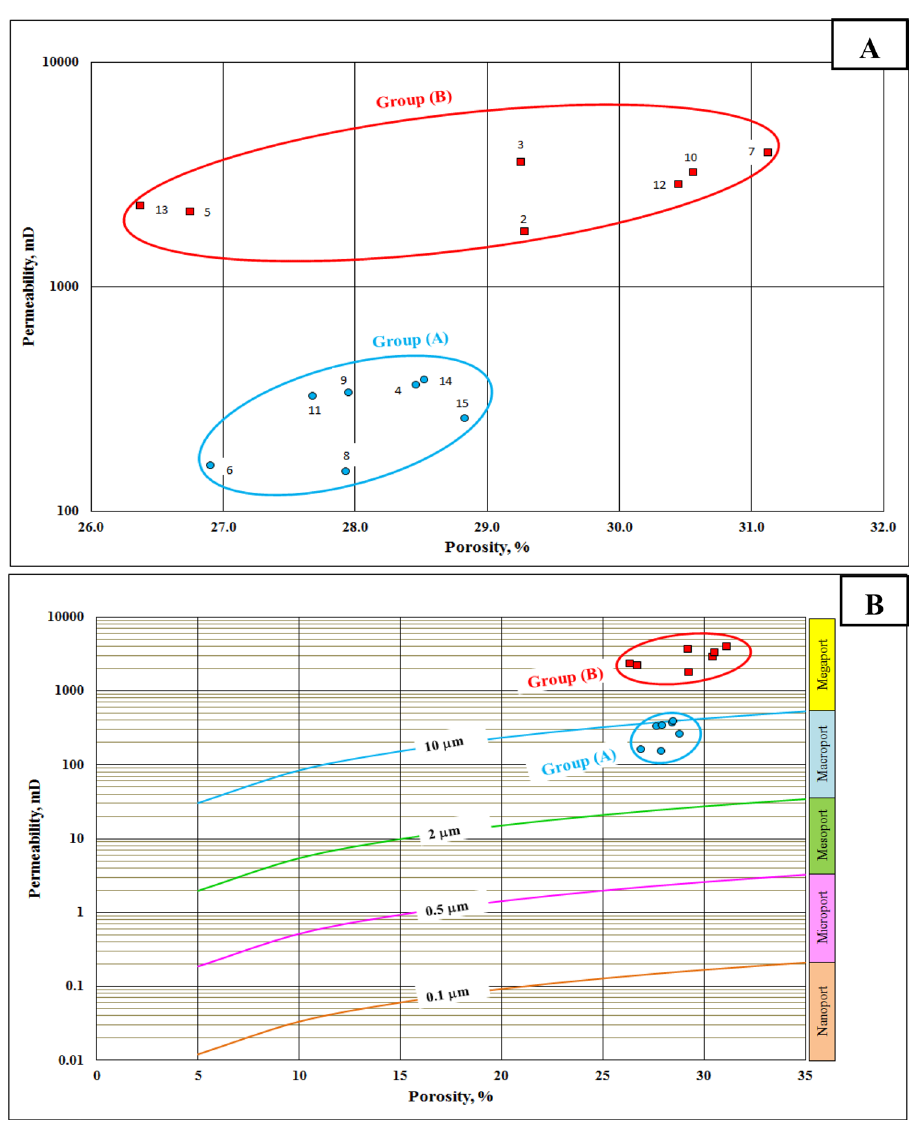
Fig. 5 a Permeability (mD) versus porosity (%) b flow units differentiation using Winland flow